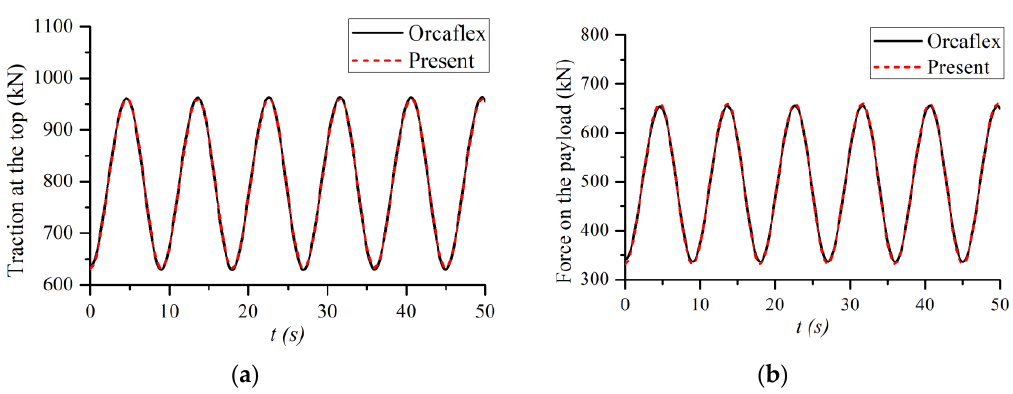
Figure 5. Comparison of the traction under the sinusoidal crane tip excitation ( H s = 0.3 m, T s = 9 s) with a payout speed of 0.2 m/s at 1500 m depth: ( a ) at the top of the cable, ( b ) on the equipment.